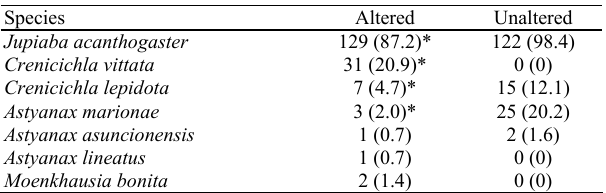
Table 2. Frequency of species acting as followers in the altered and unaltered sites, córrego Olho d’Água, Central-West Brazil. Numbers in parenthesis indicate percentage. Total does not reach 100% because some interactions occurred with more than one follower species. *indicates p < 0.05 in between areas